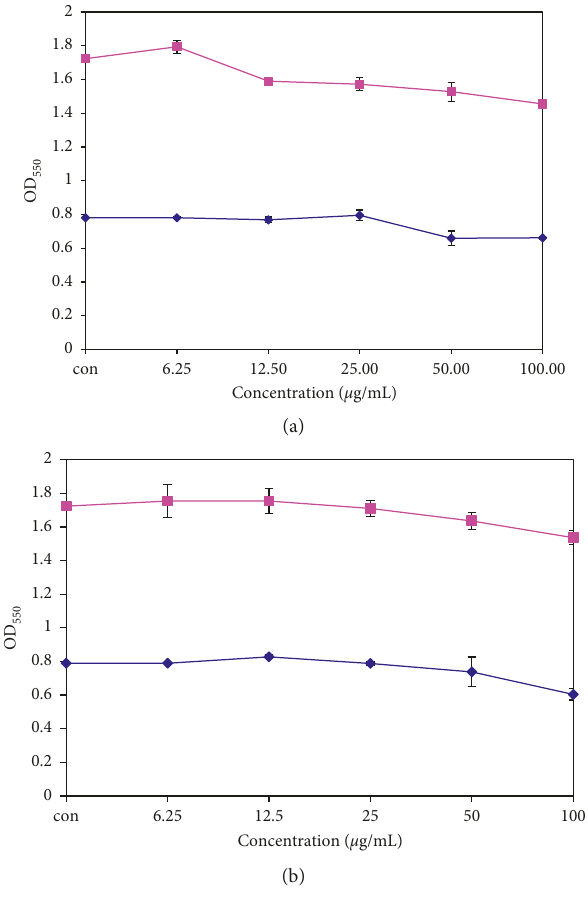
Figure 2: Cytotoxic effect of samples (a) S7 and (b) S8 . Pink: MRC5 cells; blue: HT29cells. X -axis: concentration μ g/mL; Y -axis: optical density A 550 ( n � 3). Experiments were repeated ×